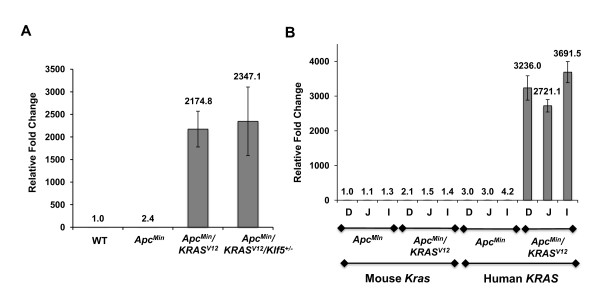
Quantification of exogenous and endogenous KRAS transcript levels in the small intestine of mutant mice. KRAS transcript levels were measured using quantitative PCR analysis. RNA was extracted from paraffin-embedded intestinal tissue samples. Endogenous (mouse) and exogenous (human) KRAS expression was measured and compared against β-actin. Fold changes were calculated for KRAS levels against β-actin levels using the 2-ΔΔCt method of relative quantification [60]. (A) Relative fold changes in exogenous (human) KRAS transcript levels in mutant mice compared to the wild type (WT) mice (designated as 1). (B) Relative fold changes in mouse Kras and human KRAS transcript levels in different regions (D = duodenum; J = jejunum; I = ileum) of the mutant mouse intestines.